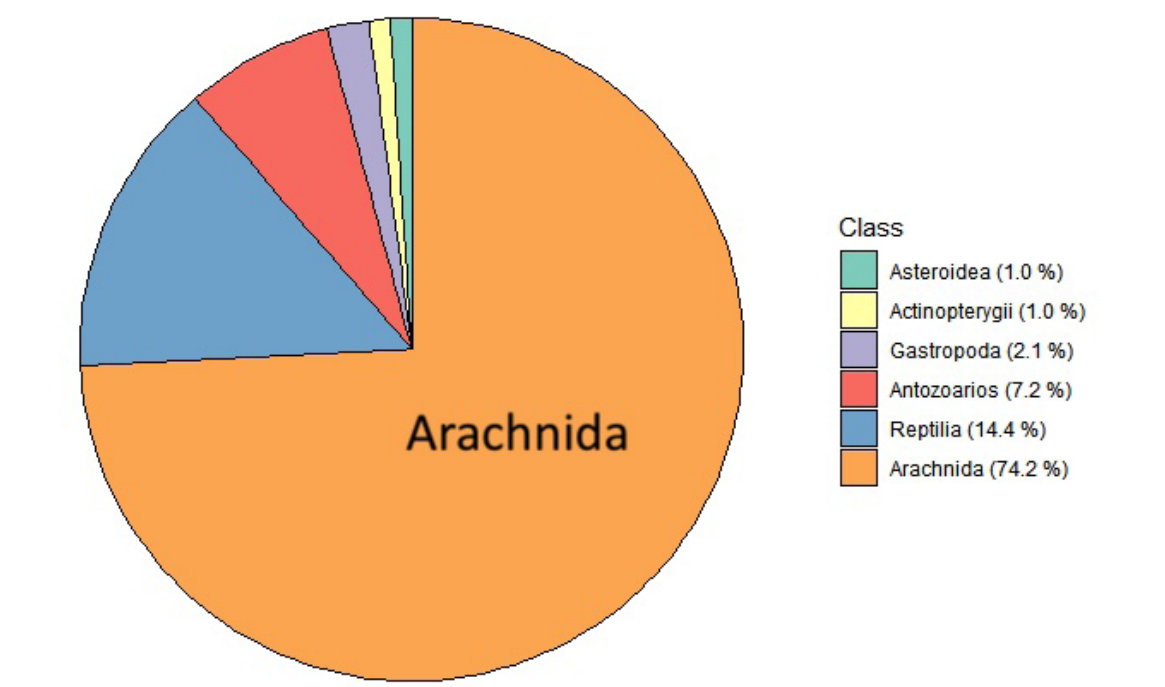
Figure 5. Similarity percentages (at class level) of Phonotimpus pennimani transcripts related to toxins or putative toxins (Figure 3; 56.32%).